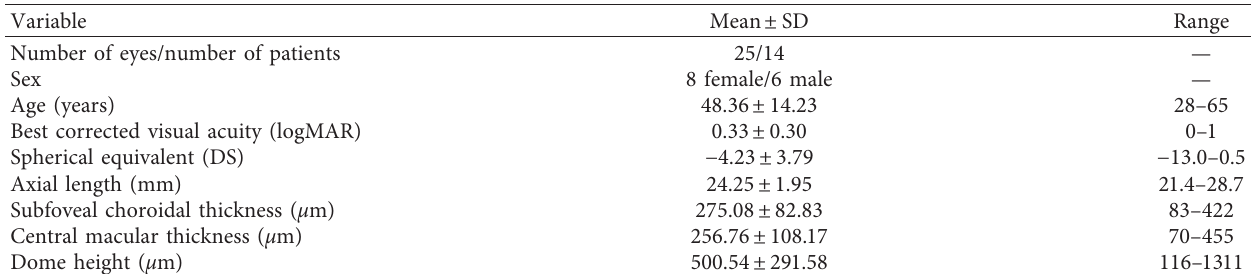
Figure 1: Horizontal (a and c) and vertical (b and d) spectral-domain optical coherence tomography (SD-OCT) scans at the fovea of a vertical dome (upper panel) and a horizontal dome with subretinal fluid (SRF) (lower panel). (d) Measurement of dome height in a horizontal dome with SRF on SD-OCT scan—line 1 is a line passing through the center of the fovea, perpendicular to line 2 passing tangential to the outer border of the retinal pigment epithelium (RPE) at the edges of the dome. The distance between the intersection of line 1 with RPE and intersection of lines 1 and 2 represents the dome Table 1: Clinical characteristics of study population.